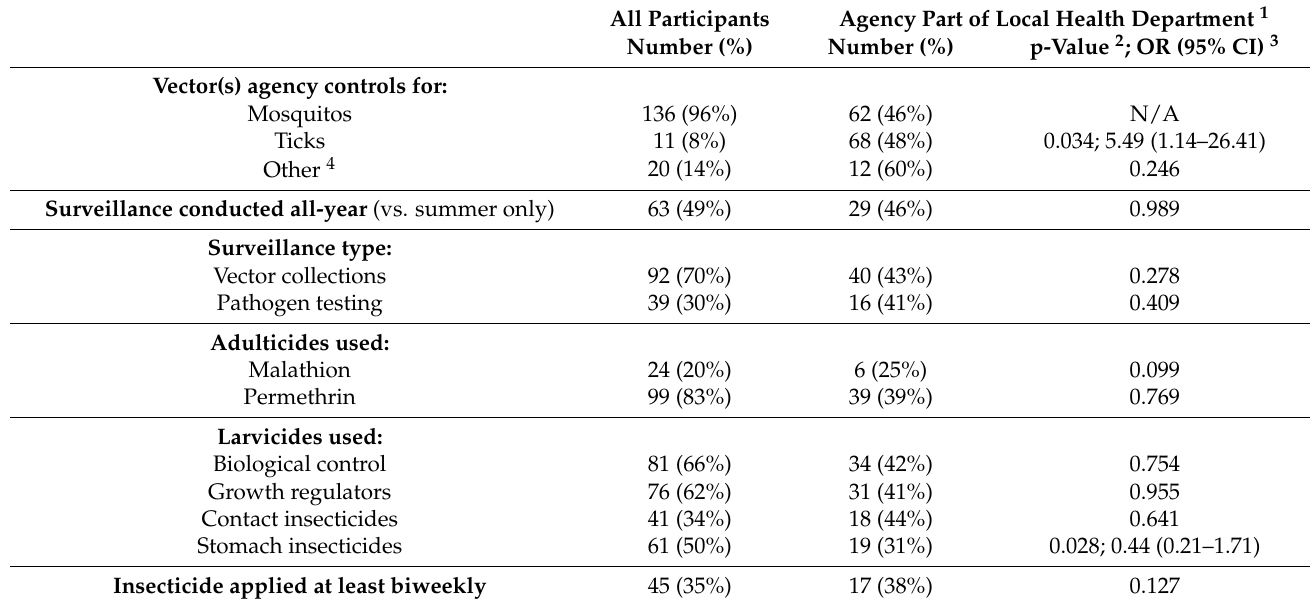
Table 2. Organizational capacity stratified by agency type. All